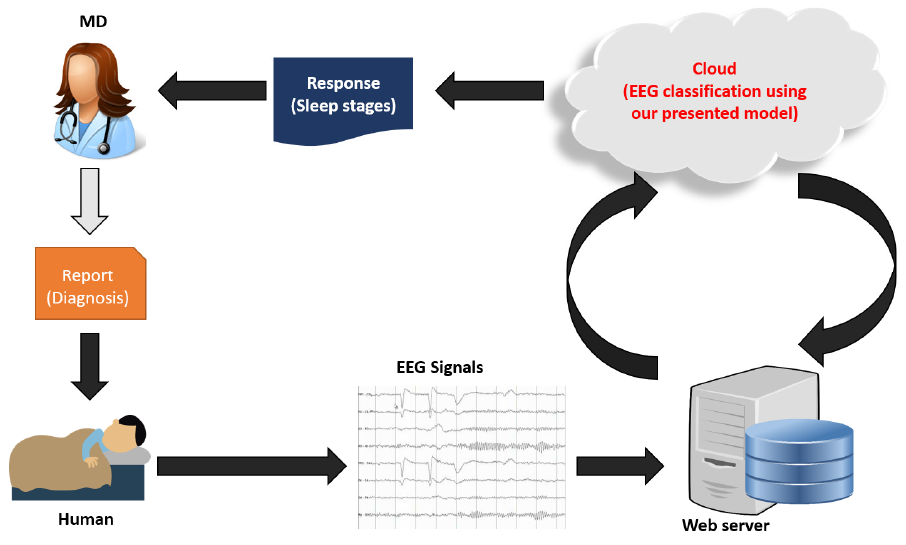
Figure 8. The intended automated sleep stage classification and monitoring model.